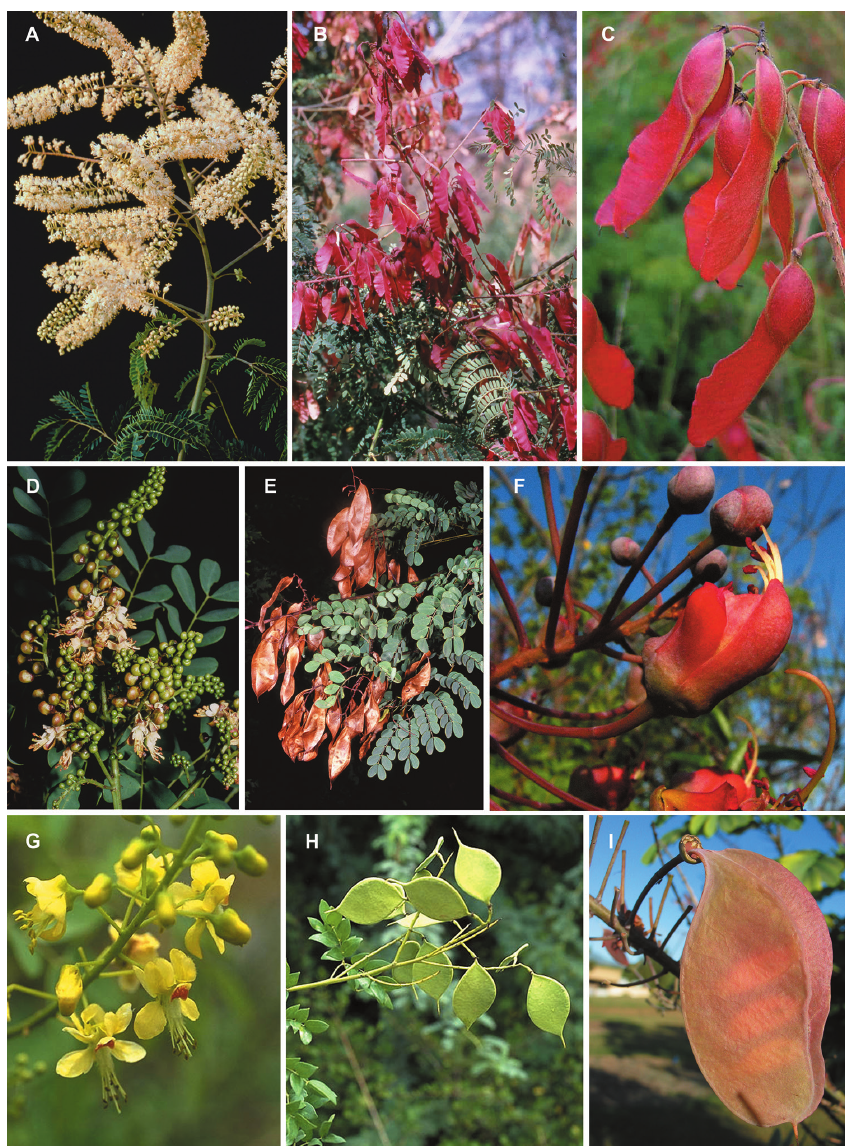
Figure 24. Pterolobium stellatum (Forssk.) Brenan. A inflorescences (P. van Wyk, Africa, unvouchered ) B fruits (J. Anton-Smith, Africa, unvouchered ) C close up of fruits (B. T. Wursten, Flora of Zimbabwe (http://www.zimbabweflora.co.zw/speciesdata/image-display.php?species_id=127190&image_id=1), Zimbabwe, unvouchered ). Mezoneuron hildebrandtii Vatke D inflorescences (D. Du Puy, Majunga, Mada- gascar, Du Puy M286 (P)) E fruits (D. Du Puy, Antsiranana, Madagascar, Du Puy M273 (P)). Mezoneur- on kauaiense (H. Mann) Hillebr. F flower and buds I fruit (D. Eickhoff, Wikicommons (https://com- mons.wikimedia.org/wiki/Category:Mezonevron_kavaiense) cultivated, Hawaii, U.S.A., unvouchered ). Caesalpinia crista L. emend. Dandy & Exell (? Ticanto ) G flowers H young fruits (P. Grard: Institut Français de Pondichéry, Andhra Pradesh, India, unvouchered